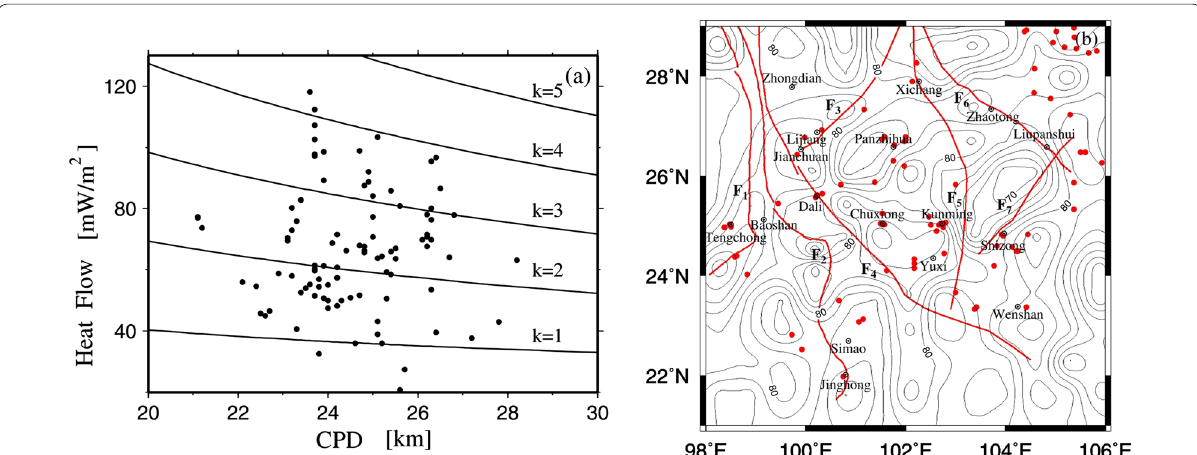
Fig. 5 a Scatter plot of the Curie surface and surface heat flow value, and the curves corresponding to k the heat flow and Curie surface calculated using the 1-D heat conduction model. b Heat flow distribution at the Curie point depth estimated using the 1-D heat conduction model (coefficient of thermal conductivity k